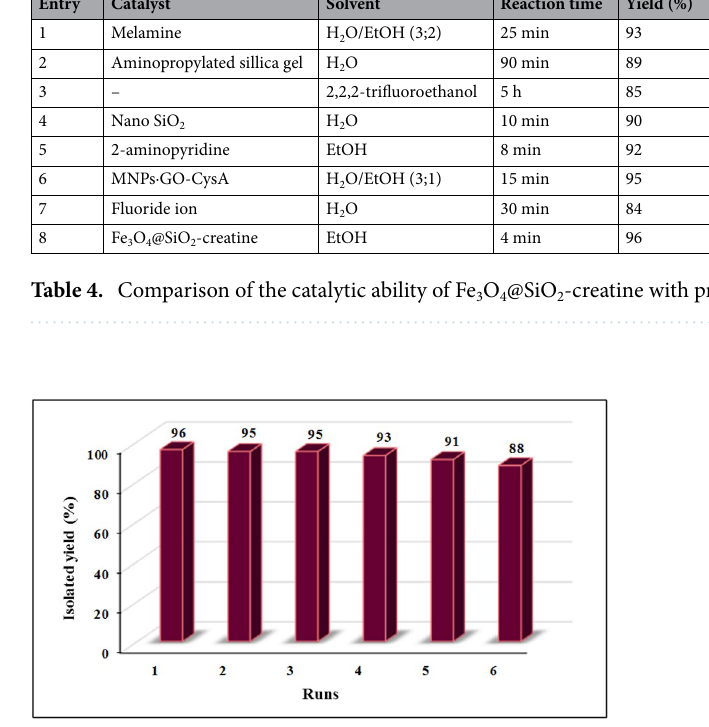
Figure 8. Reusability of Fe 3 O 4 @SiO 2 -creatine nanobiocatalyst for the synthesis of 4c